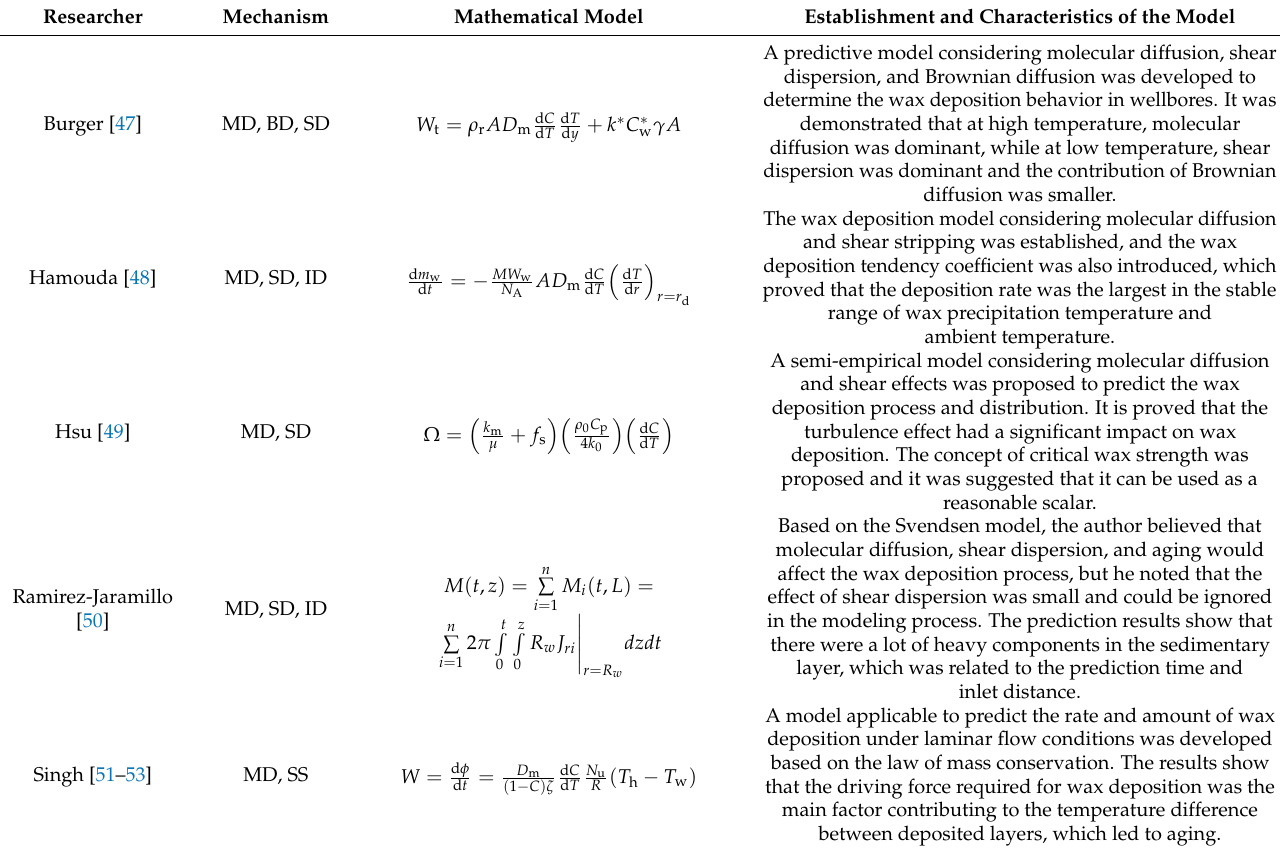
Table 1. Summary of single-phase wax deposition